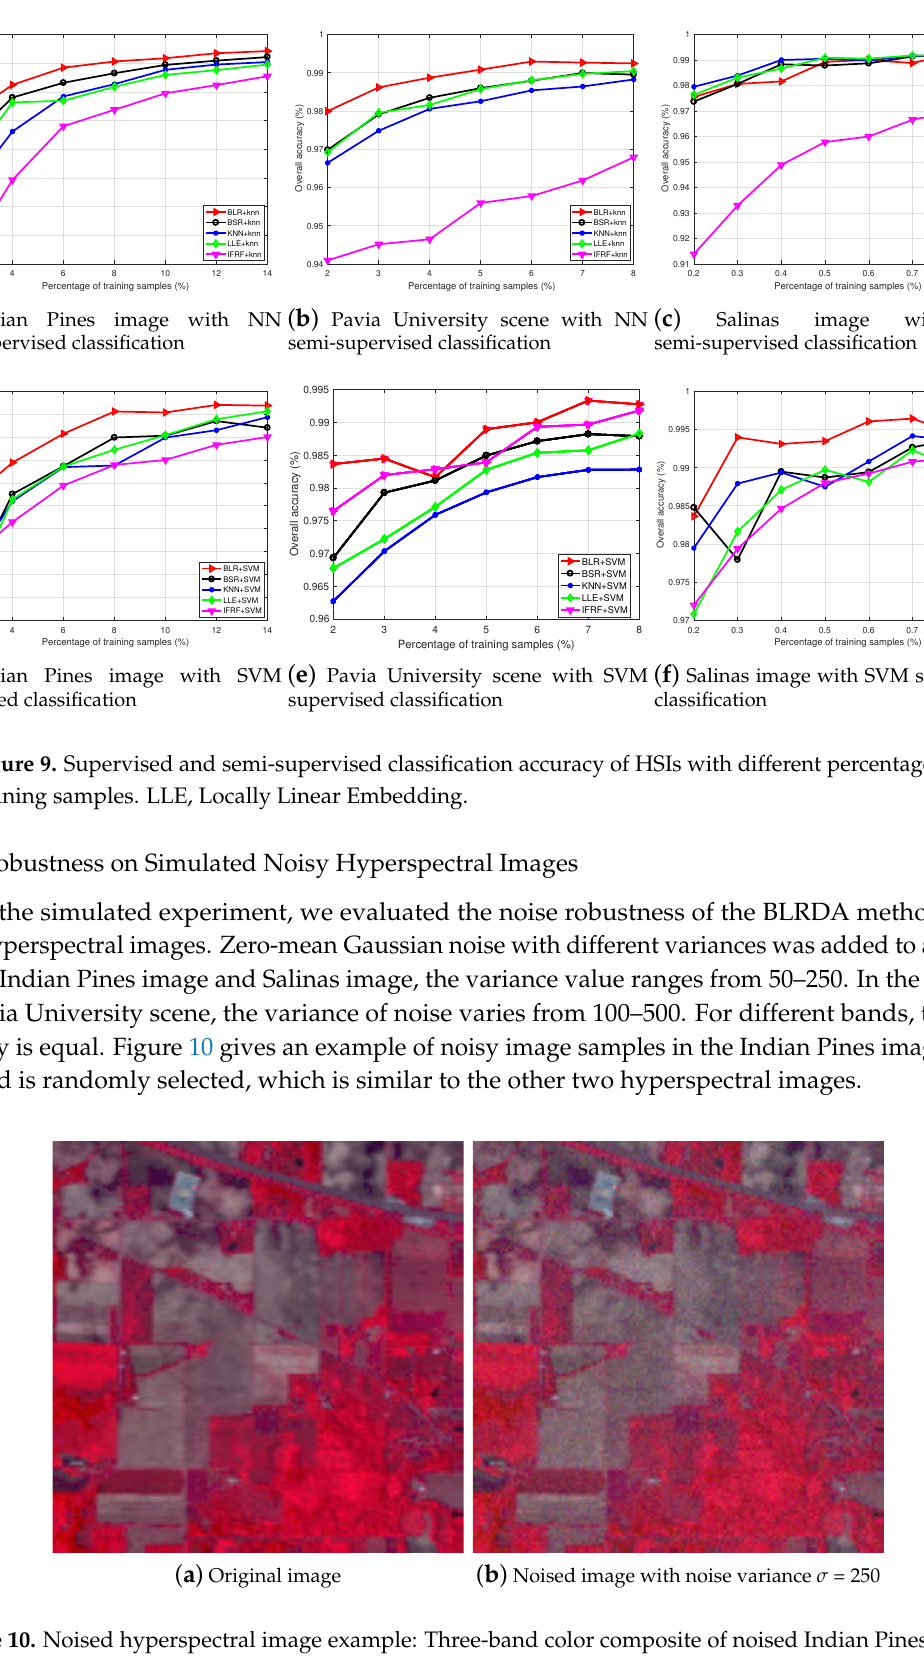
Figure 10. Noised hyperspectral image example: Three-band color composite of noised Indian Pines